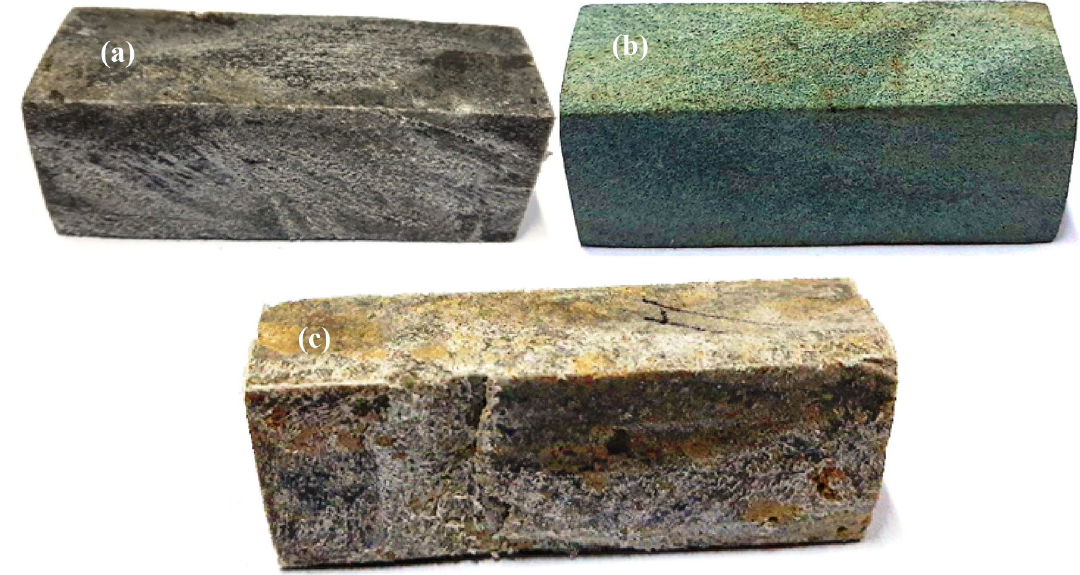
Figure 7. Images of prepared specimens ( a ) 50% of low-density polyethylene, ( b ) 50% of high-density polyethylene, ( c ) 50% of low-density polyethylene and 20% polyethylene terephthalate.